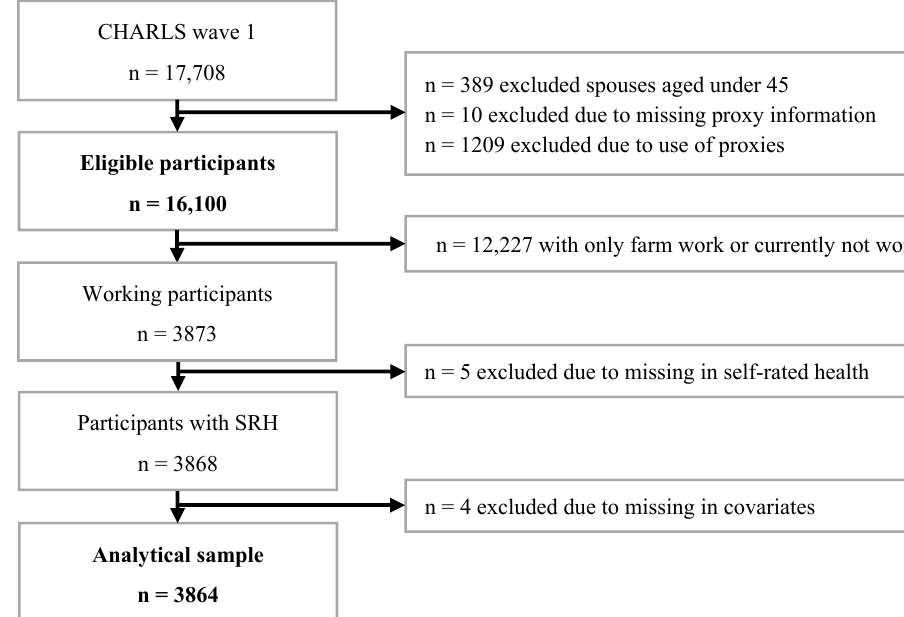
Figure 1. Flowchart of the sample-selection